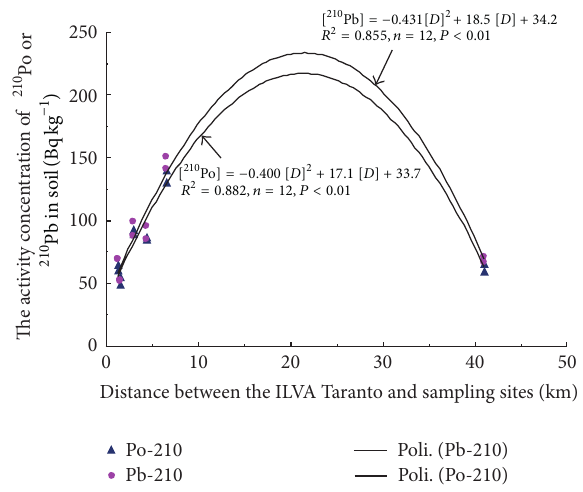
Figure 2: The activity concentration of 210 Po and 210 Pb as a function of the distance ( D ) between the ILVA Taranto and sampling